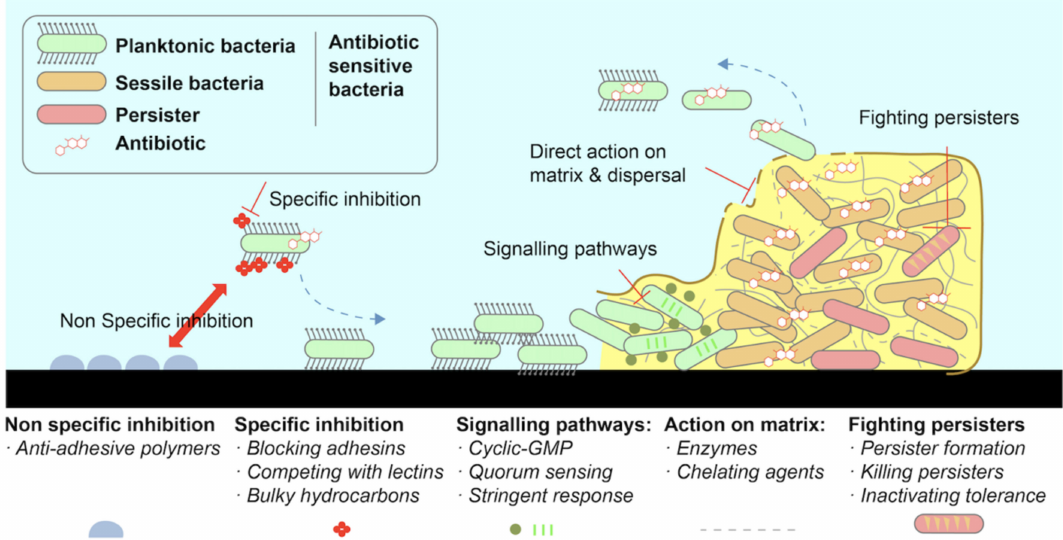
Figure 4. Different biological mechanisms to inhibit biofilm growth